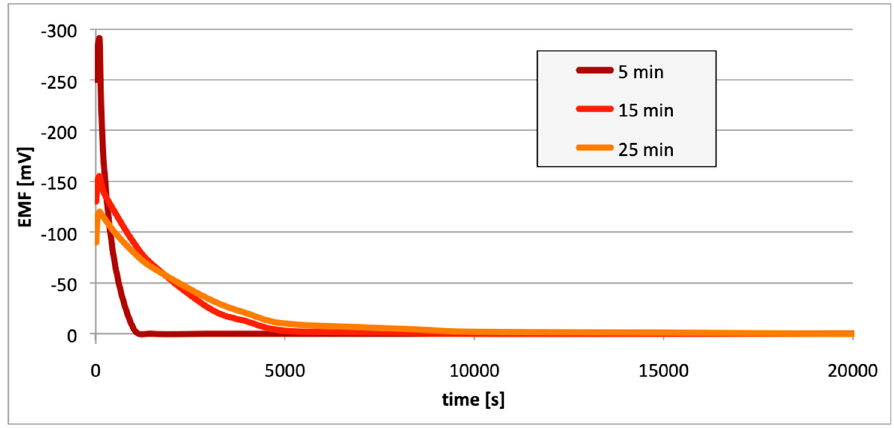
Figure 12. Decrease of cell EMF in time accompanying hydrogen desorption (EN AW-6060). Hydrogenation time: 5, 15, and 25